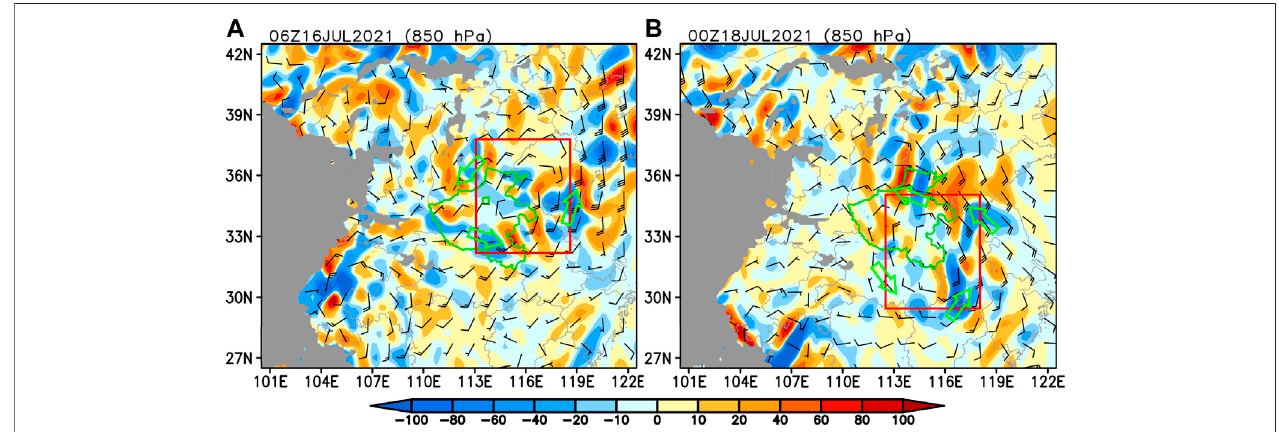
FIGURE 9 | Term HAV (shading, units: 10 − 10 s − 2 ) and wind fi eld at 850 hPa (a full bar represents 4 m s − 1 ), where the red box outlines the main body of the vortex, and the big open green vector mark the key transport of vorticity that resulted in a negative HAV.